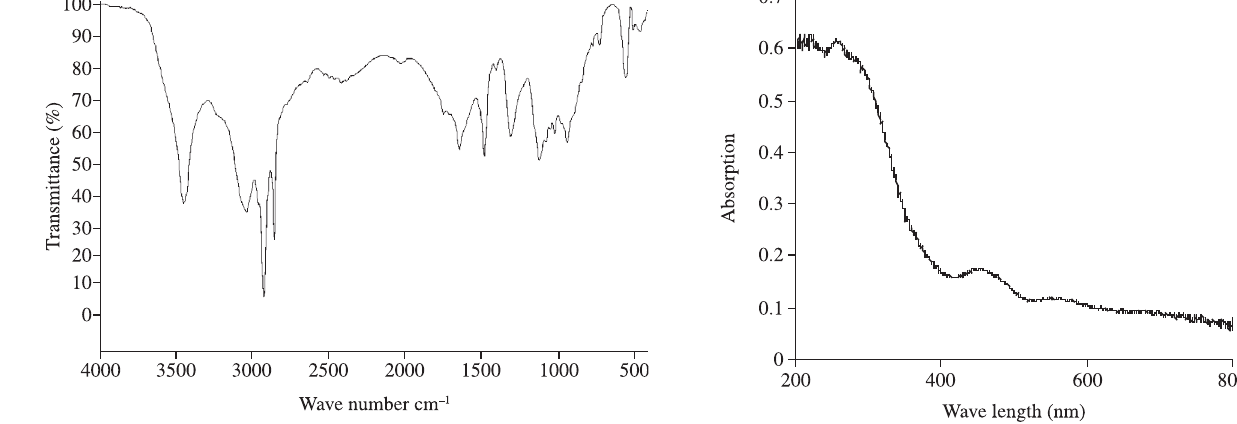
Scheme 1. A plausible mechanism for mesoporous Mn – organophosphate molecular sieve